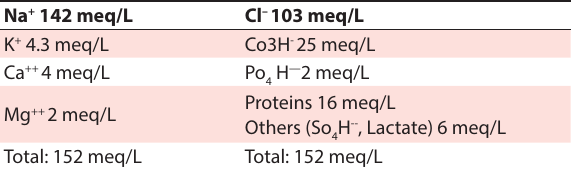
Table 1. Normal values of serum electrolytes